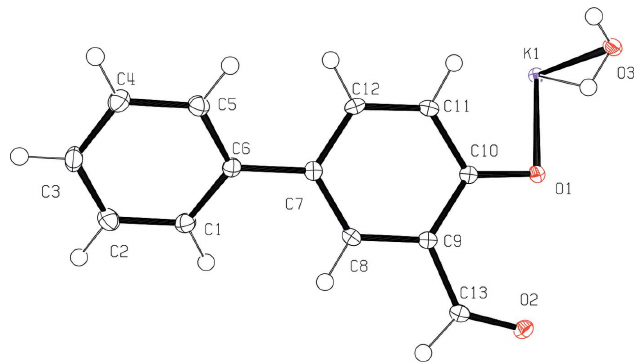
Figure 1 The structure of the title compound, with displacement ellipsoids drawn at the 50% probability